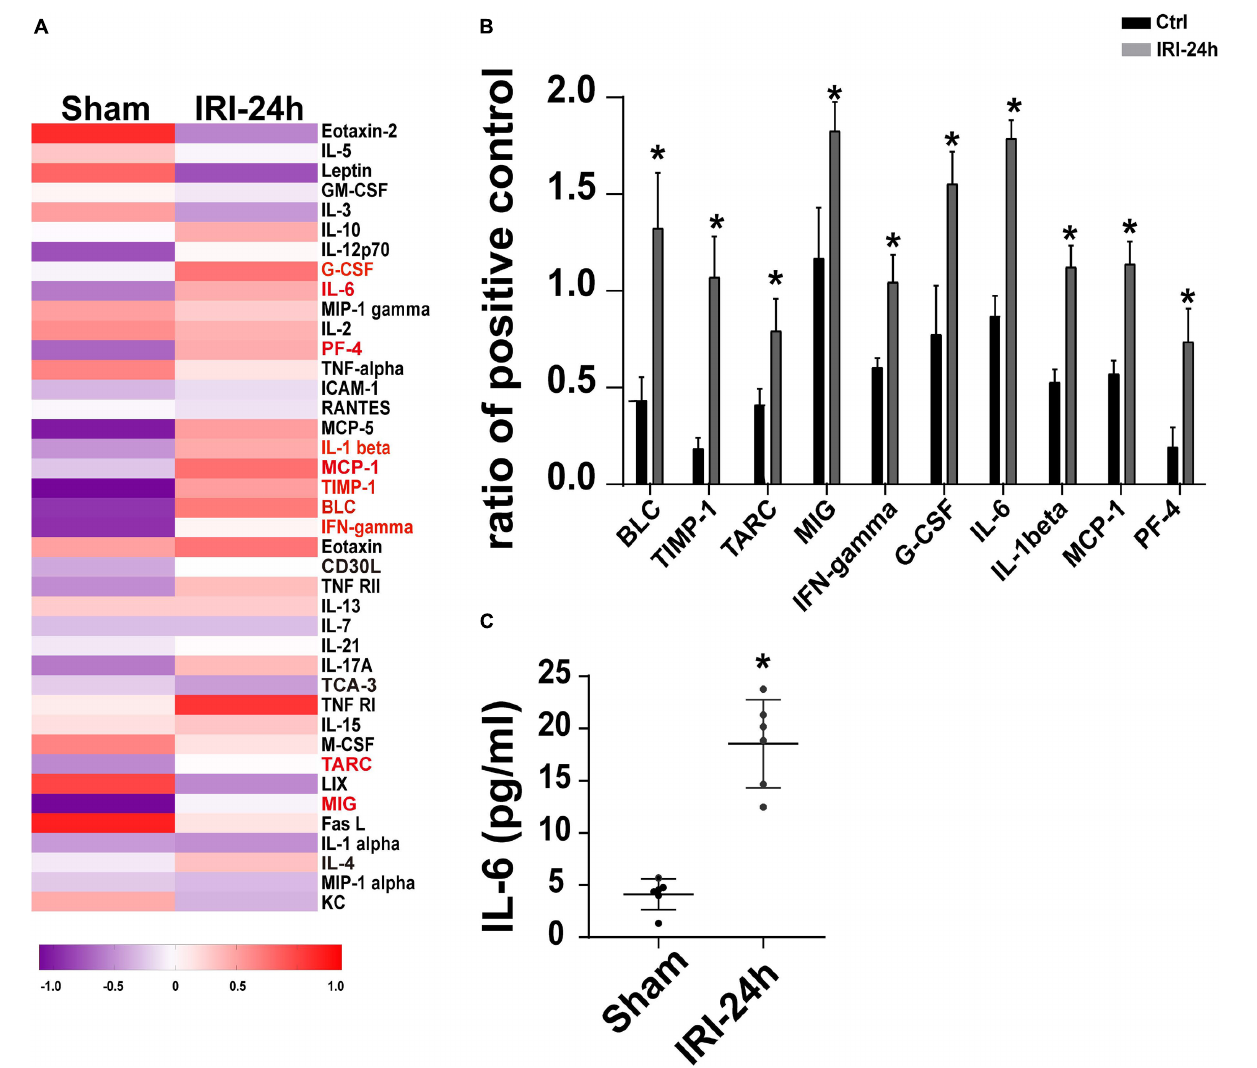
FIGURE 6 | Circulating IL-6 expression is increased in response to acute kidney injury (AKI). (A) Heat map of altered serum cytokines differentially expressed in the heart 24 h after AKI. (B) The altered serum cytokines in 24 h after AKI. (C) ELISA was used to analyze the alterations of circulating IL-6 after AKI. * p < 0.05 vs. sham